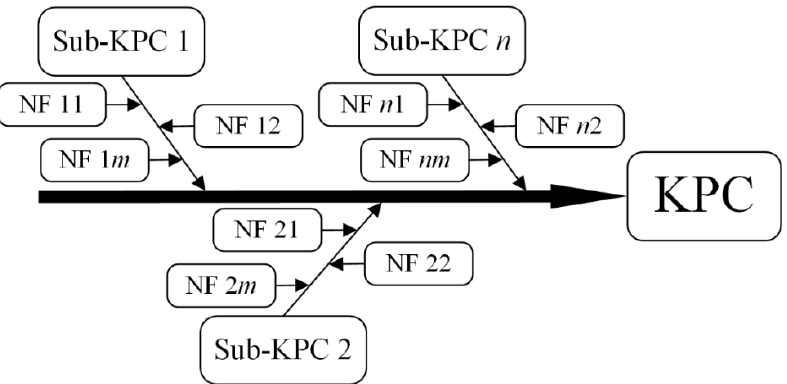
Figure 3. Variation transfer model—Ishikawa diagram.